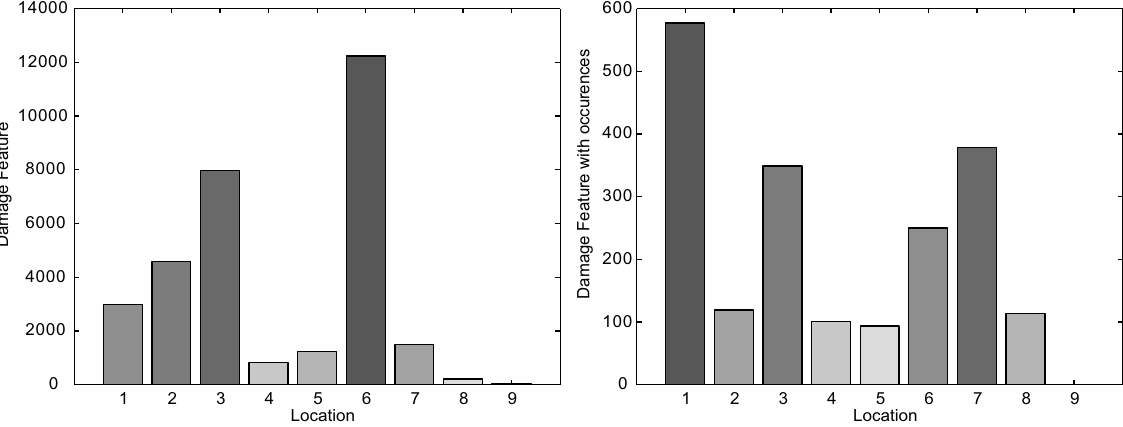
Fig. 12. Damage feature without and with occurrences for damaged structure and changing loading conditions, frequency range 1–200 Hz.